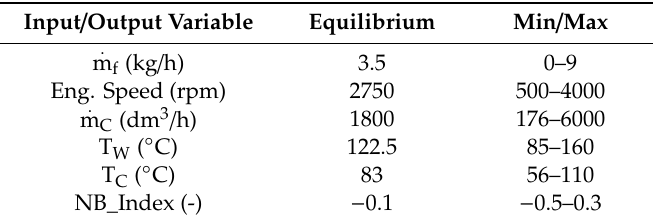
Table 1. Constraints on input and output variables for Ellipsoid No.1.